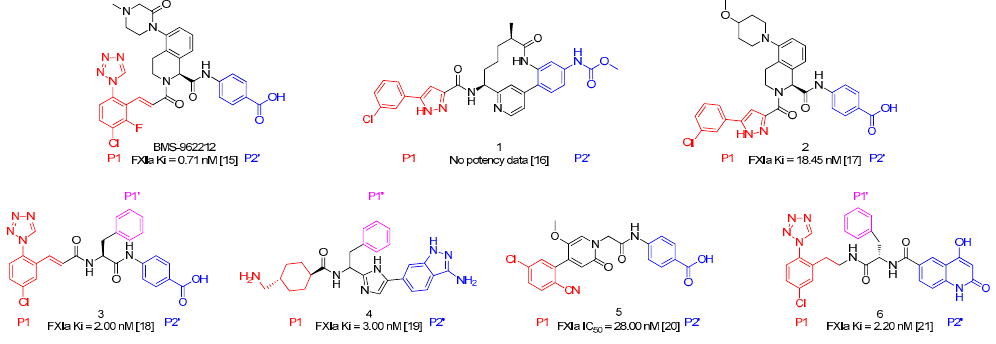
Figure 1. The representative FXIa inhibitors.